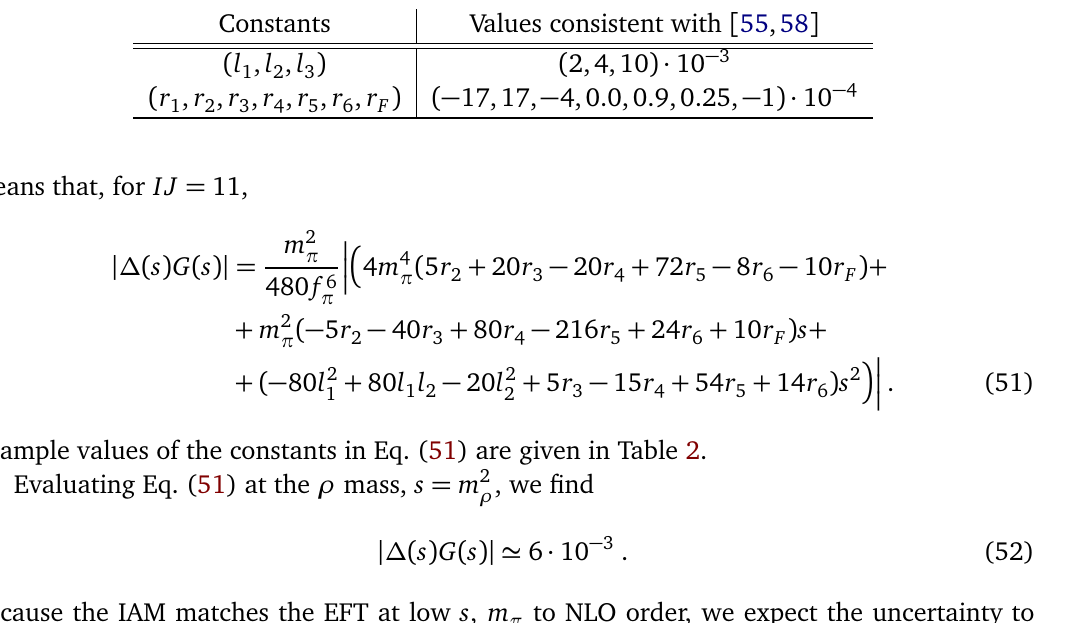
Table 2: Renormalized scattering constants up to NNLO which we interpret as evalu- ated at the renormalization scale µ = ρ = 770 MeV, this being the mass of the most prominent high-energy resonance eliminated to obtain